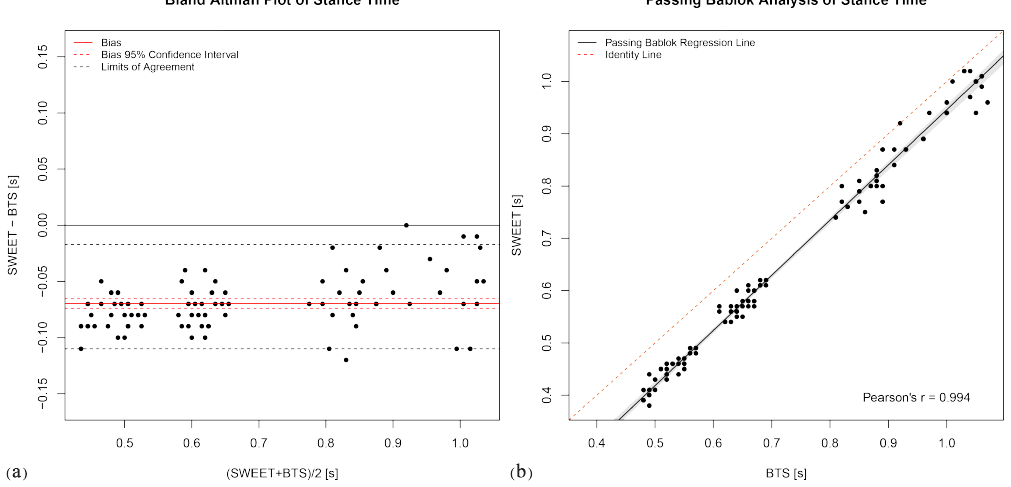
Figure 8. Stance Time: ( a ) Bland–Altman plot; ( b ) Passing–Bablok regression analysis.